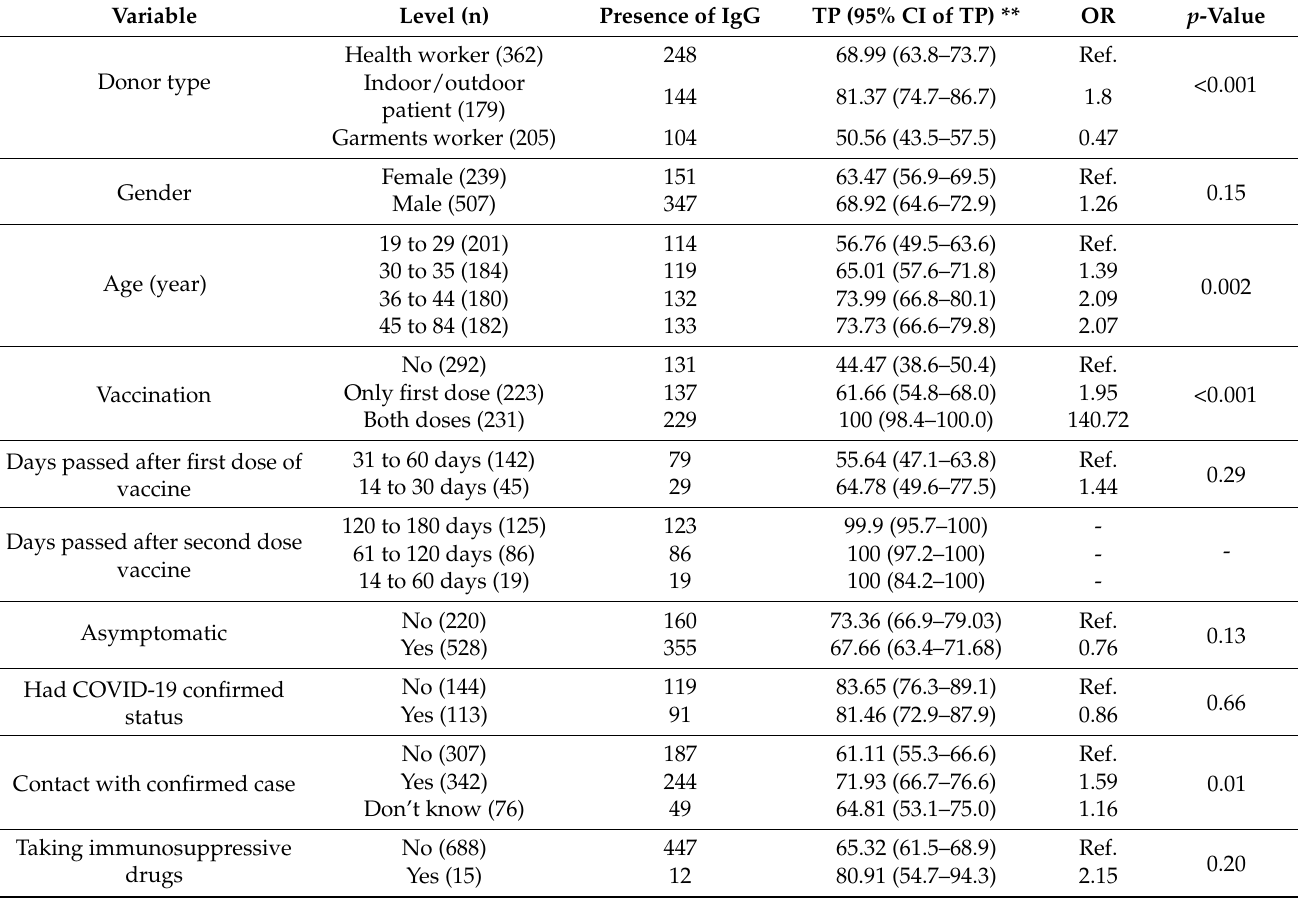
Table 4. Univariable analysis ( χ 2 test, logistic regression) to evaluate the association of different variables with the seroprevalence of anti-SARS-CoV-2